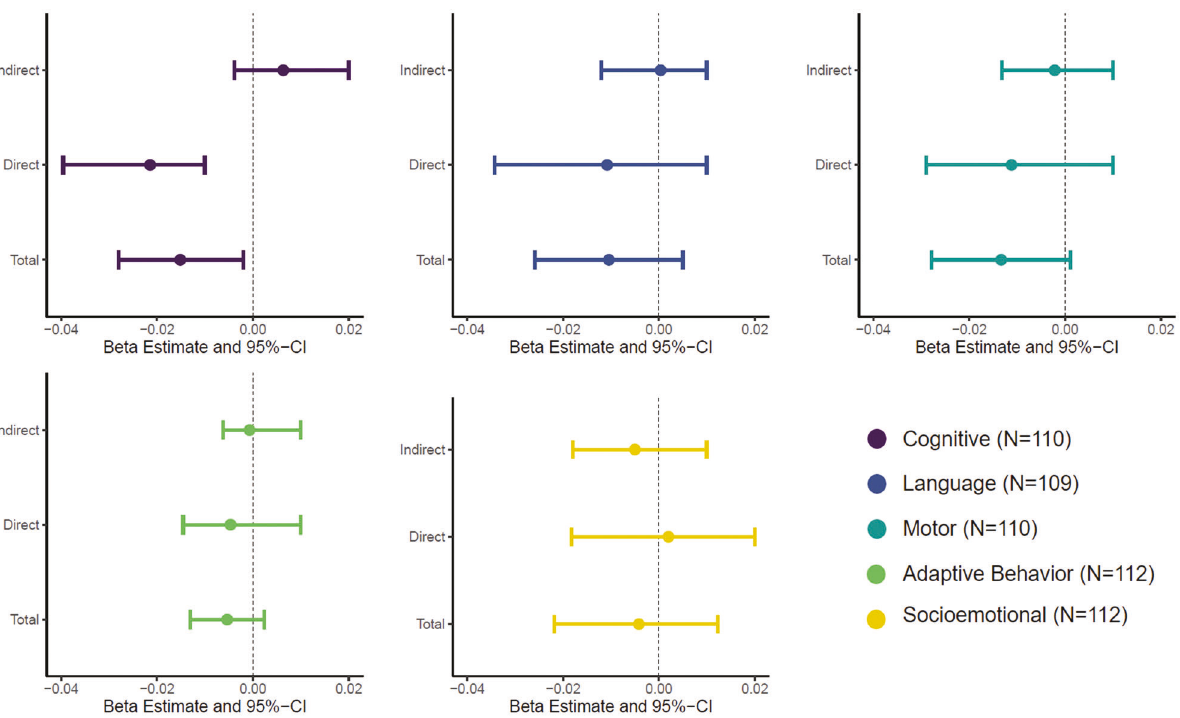
Fig. 3 Causal mediation analysis for PTE as the exposure, MRS as the mediator, and neurodevelopment across fi ve domains at 6 months of age as the outcome. Estimated indirect effect, direct effect, and total effect with their corresponding 95% con fi dence intervals are